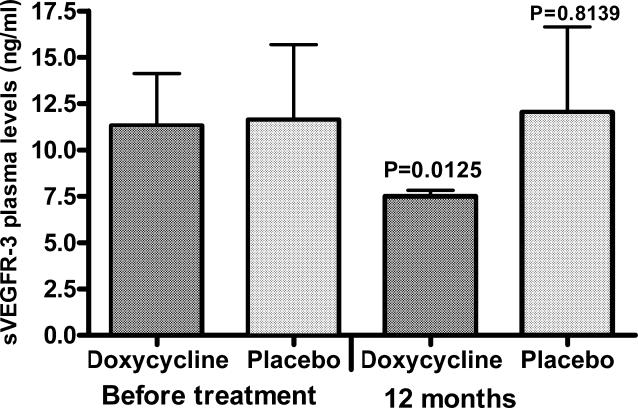
Plasma Levels of sVEGFR-3 of Microfilaremic Patients before and 12 Mo after Doxycycline TreatmentPlasma concentrations (mean ± SD) of sVEGFR-3 were measured from plasma of microfilaremic patients before and 12 mo after doxycycline treatment (17 doxycycline treated, 16 placebo, see Table 1). The sVEGFR-3 levels decreased significantly at 12 mo (preceding supratesticular lymphatic dilation, see Table 2) in the doxycycline-treated patients (p = 0.0125) to a level close to that of endemic controls whereas there was no difference in the placebo group (paired t-test).